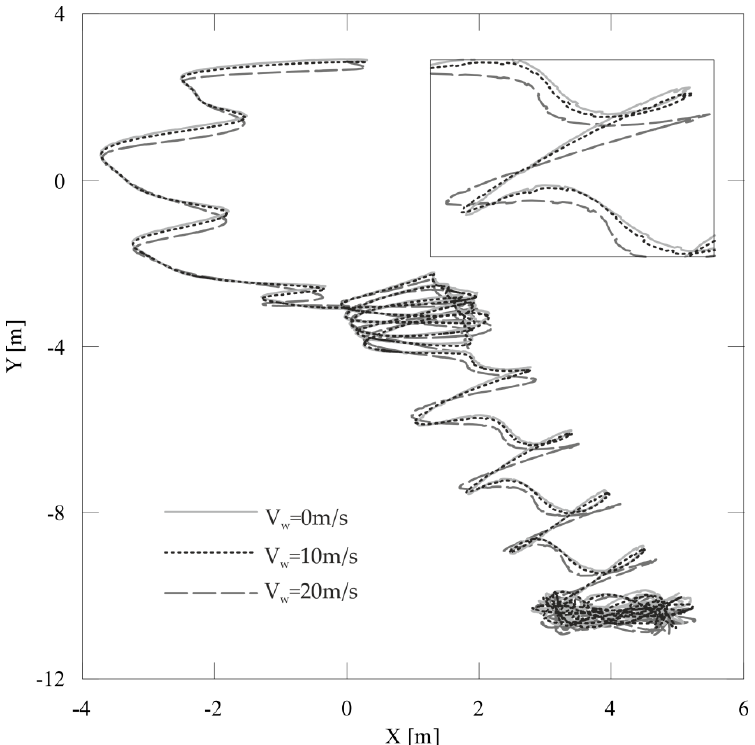
Figure 22. Trajectory projections of the carried load’s center of mass in the rotation plane (wind power having impact according to the direction of the Y axis).